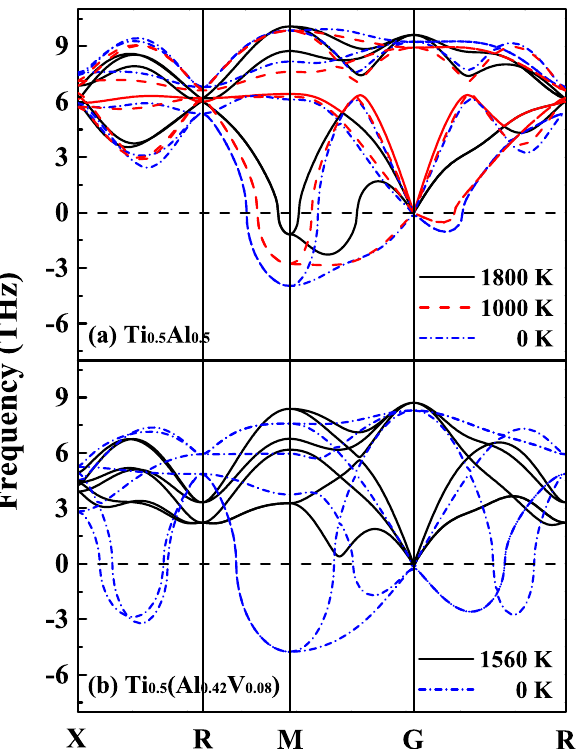
Figure 5. Temperature dependent phonon dispersion curves of β 0 -type Ti 0.5 Al 0.5 ( a ) and Ti 0.5 (Al 0.42 V 0.08 ) ( b